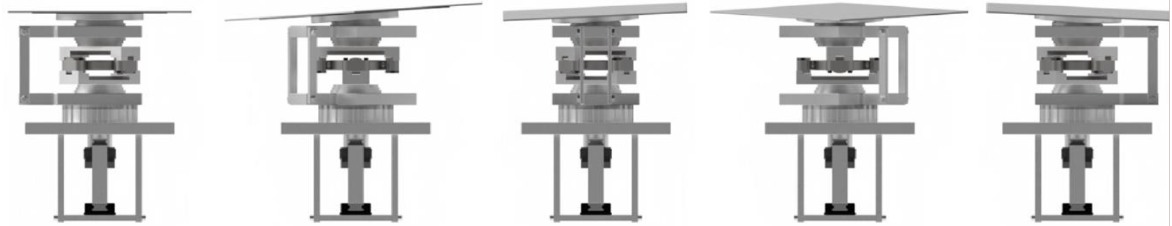
Figure 12. Schematic diagram of possible layout settings of the rotation on the motor device.